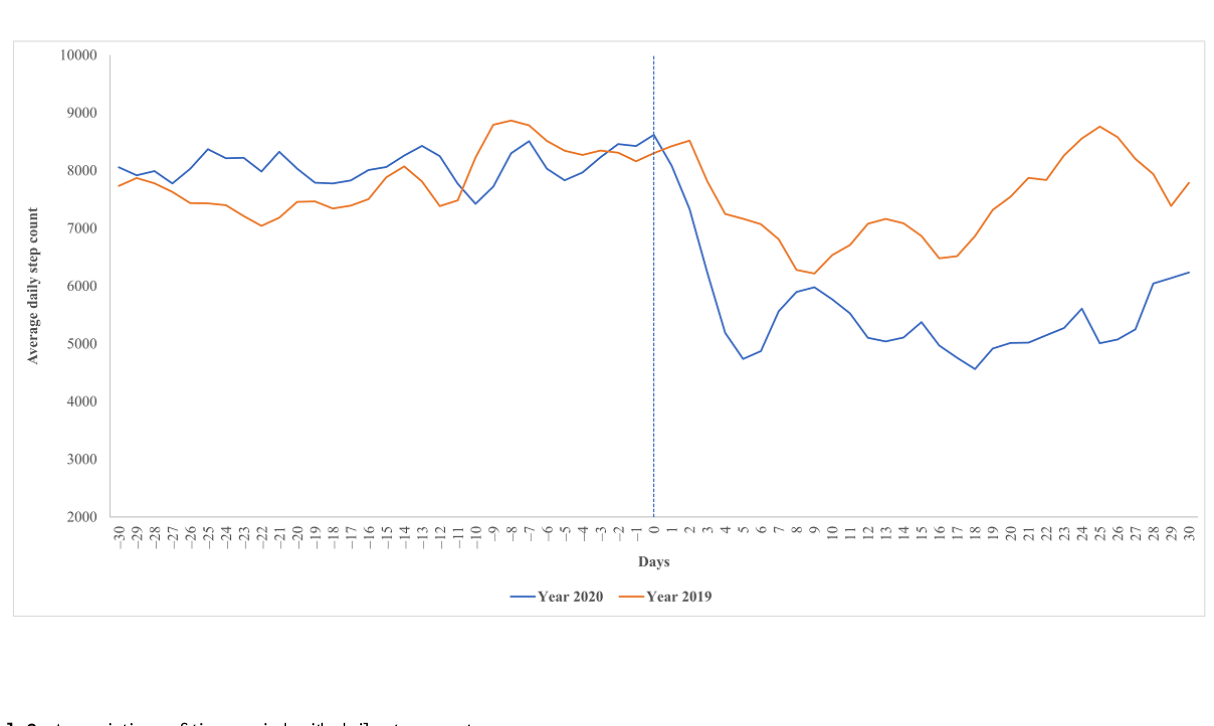
Table 2. Associations of time period with daily step